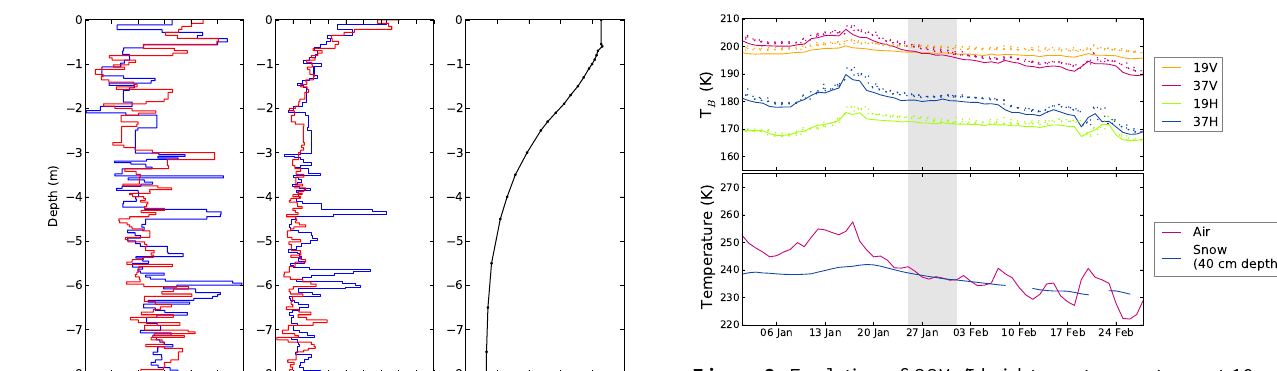
Figure 3. Evolution of SSM/I brightness temperatures at 19 and 37GHz and vertical and horizontal polarizations in January and February 2012. Air temperature measured by the Antarctic Au- tomatic Weather Station Project (AWS) and snow temperature at 50cm depth. The gray bar shows the period of ground-based radio- metric